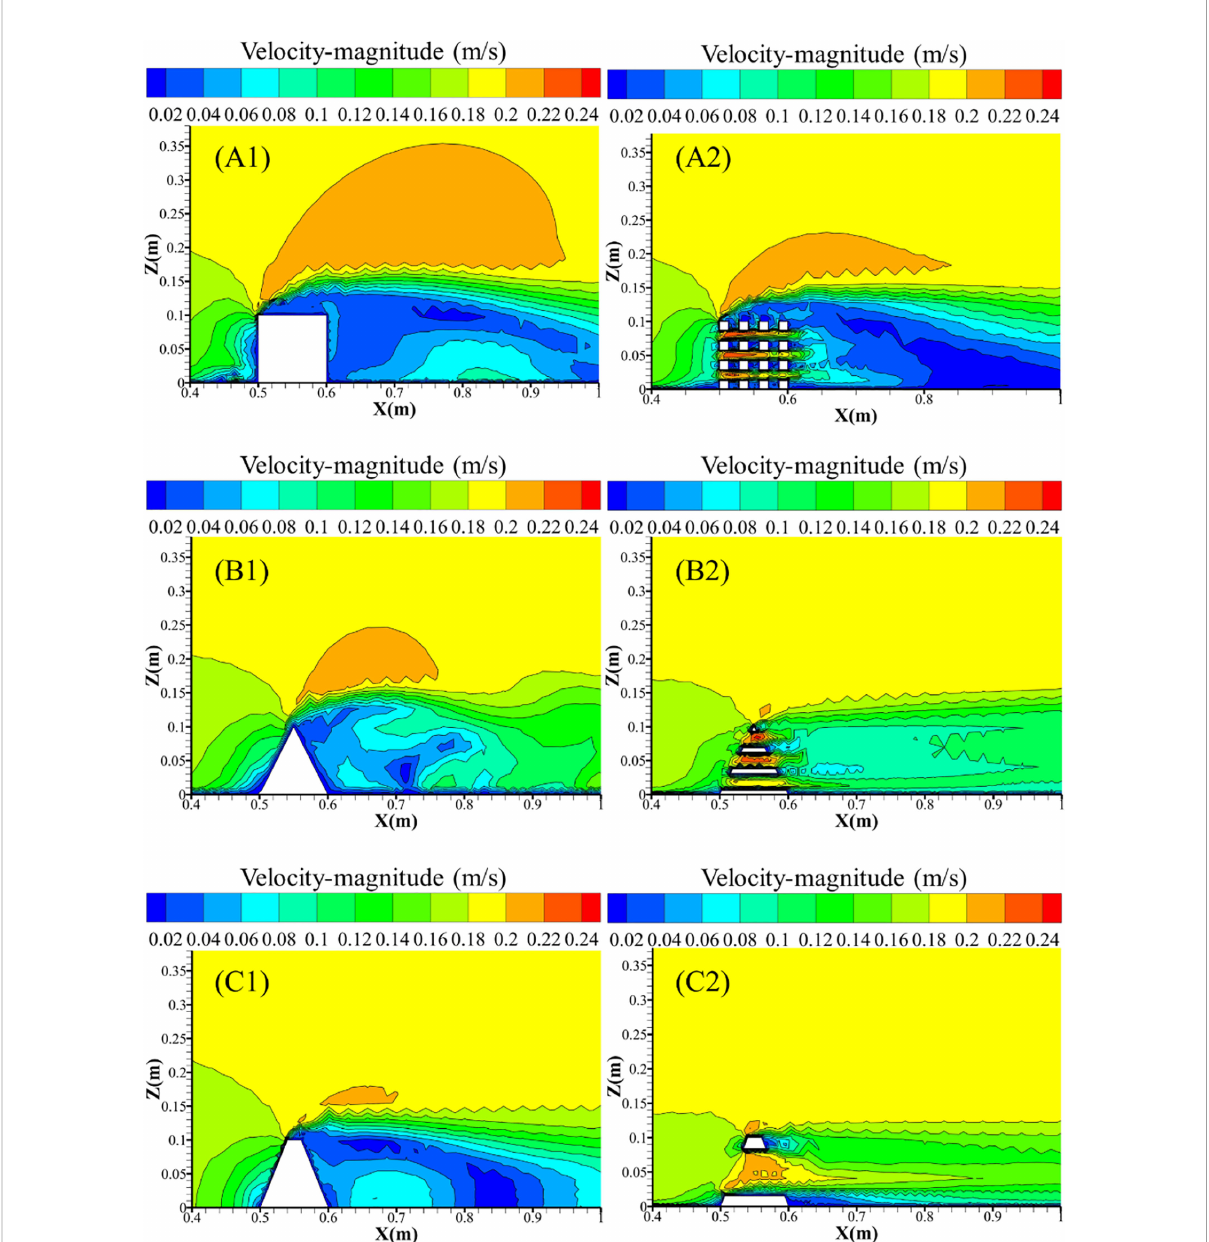
FIGURE 7 Velocity contours of the fl ow fi elds of ARs with six basic structures; (A1) Solid cube; (A2) Hollow cube; (B1) Solid triangular pyramid; (B2) Hollow triangular pyramid; (C1) Solid truncated rectangular pyramid; (C2) Hollow truncated rectangular